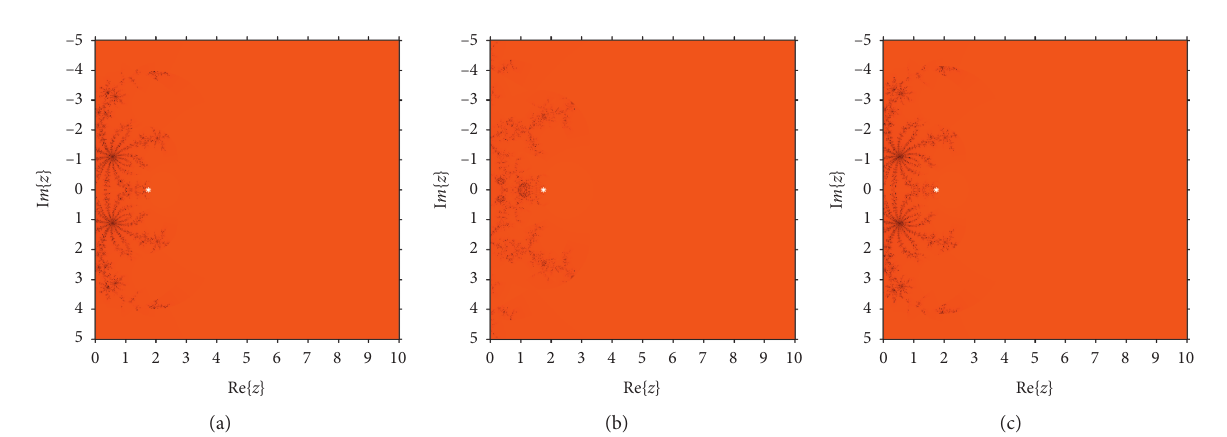
Figure 2: Basins of attraction of (a) SFM1, (b) SFM2, and (c) SFM3 for g